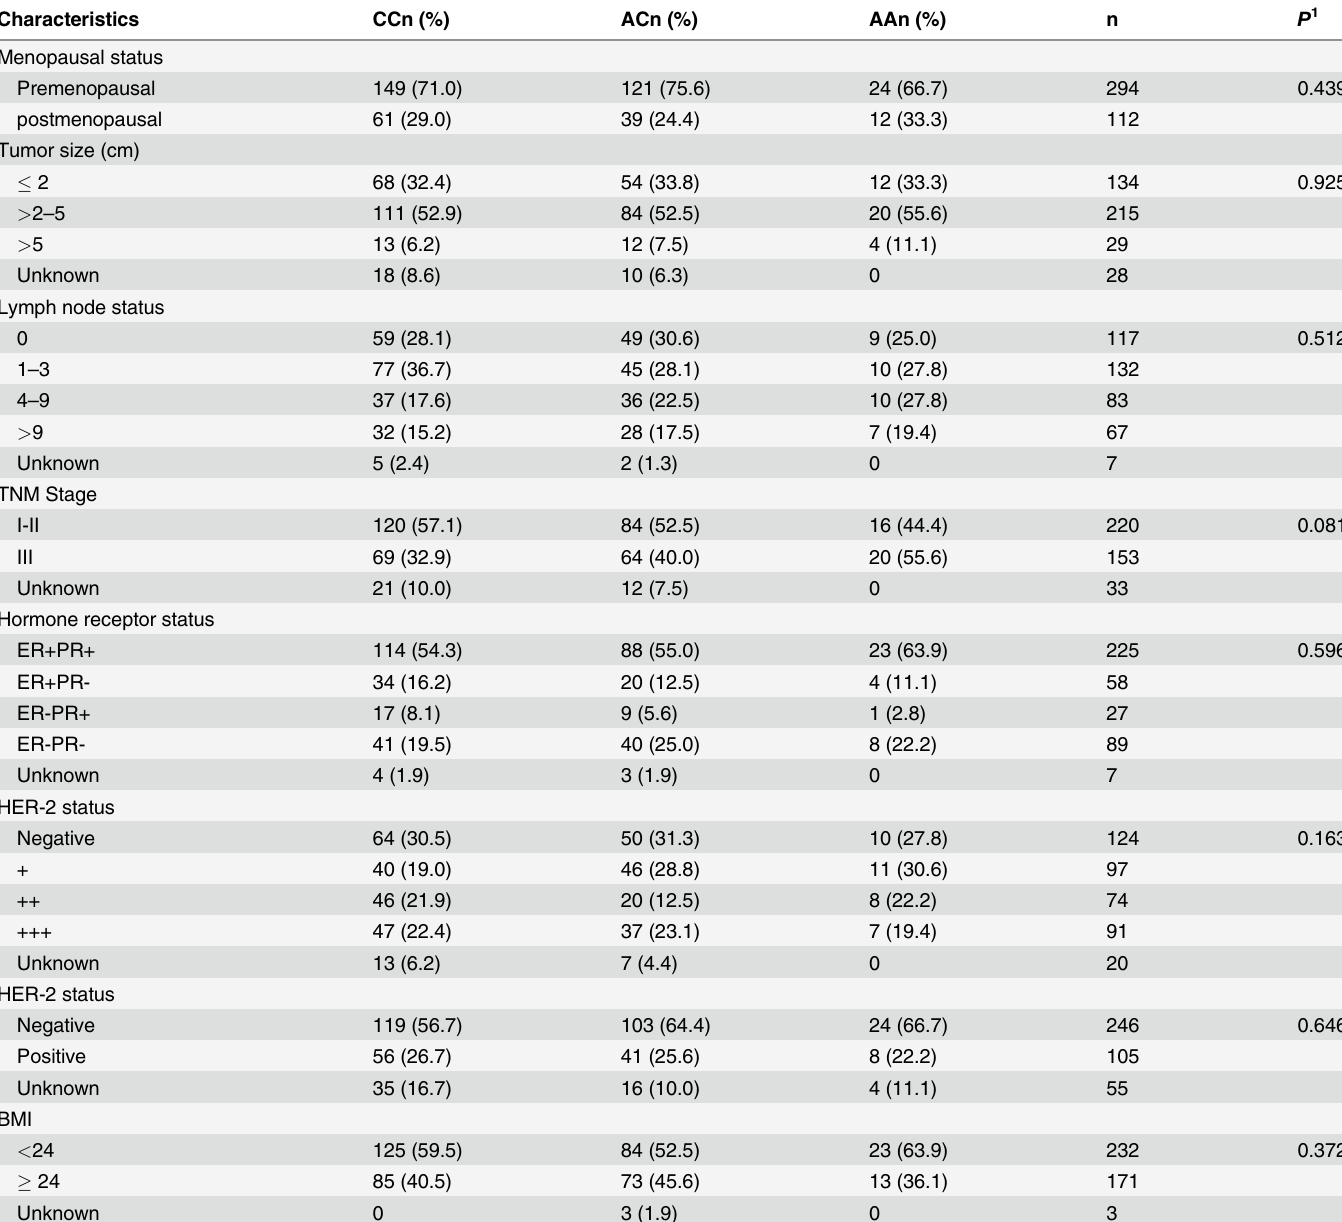
Table 1. Correlation of CYP19 polymorphism (CC vs AC vs AA) to clinical